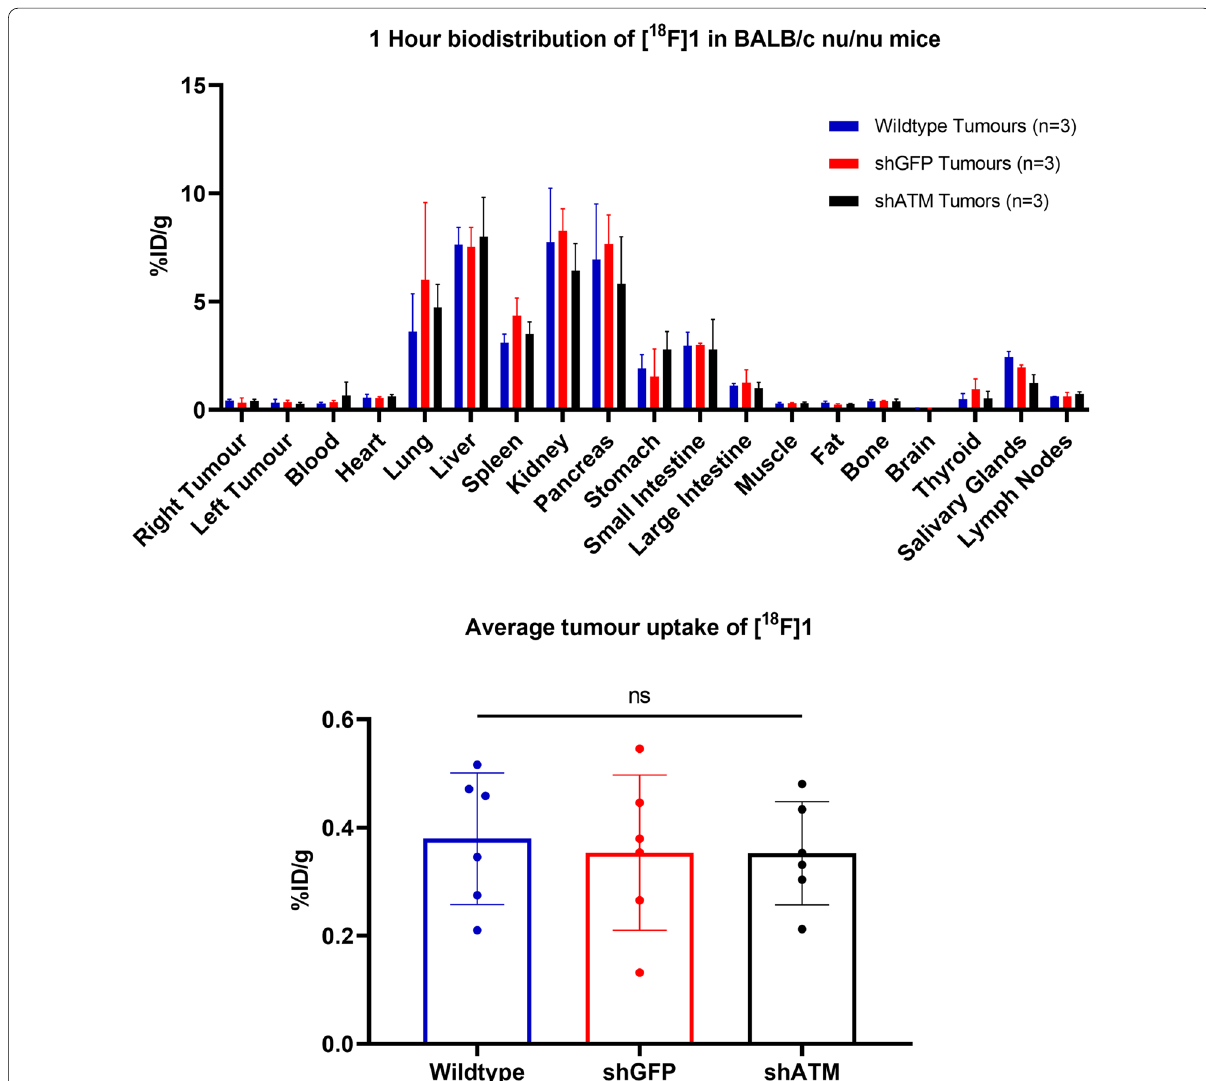
Fig. 6 In vivo biodistribution of [ 18 F] 1 in BALB/c nu/nu mice bearing subcutaneous H1299 wild type, shATM, or shGFP